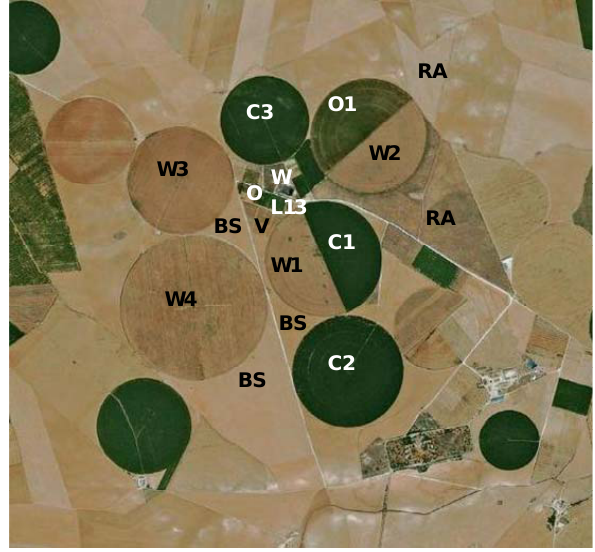
Fig. 1. Study area and fields